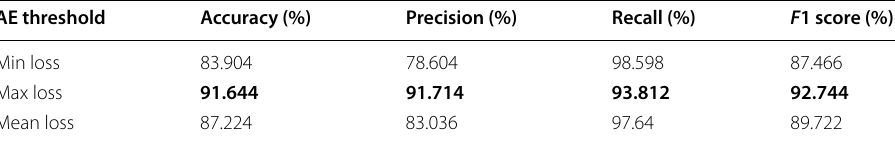
The best-performing AE threshold is marked with bold styles